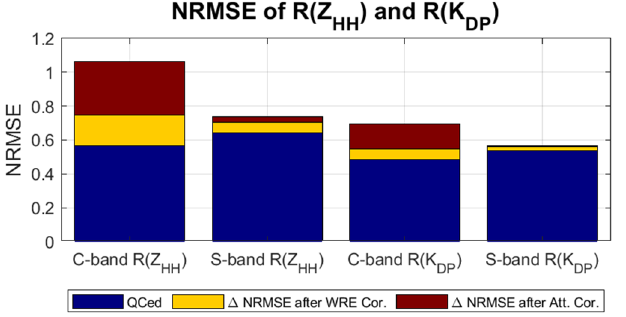
Figure 6. The NRMSEs of the C-band (refer to NCU C-POL) and S-band (refer to RCWF hereafter) QPEs at different levels of Z HH corrections. The height of each bar indicates the NRMSE after systematic-bias correction only. The brown color represents the reductions of NRMSE after the ensuing attenuation correction, and the yellow marks the reductions after the correction of the wet radome effect (WRE). The blue color is the final NRMSE when all QC procedures, including the systematic-bias, attenuation and wet-radome corrections, are completed.